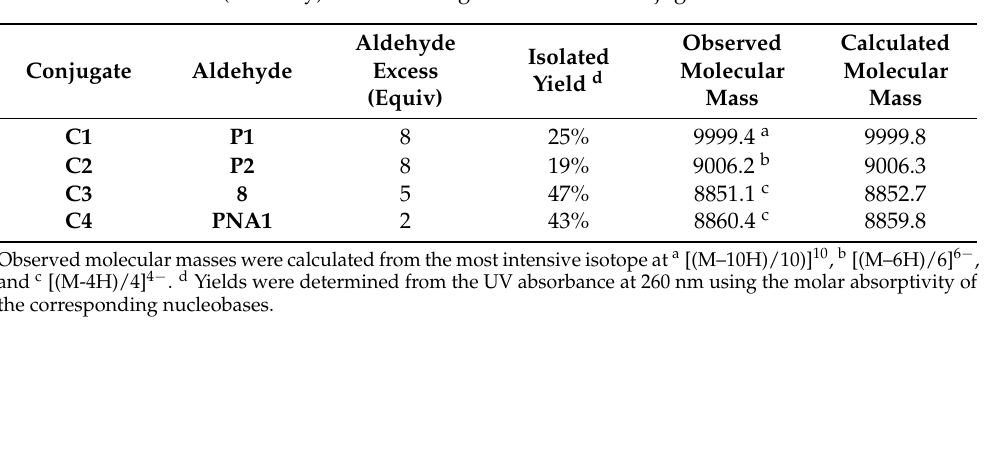
Aldehyde Observed Isolated Excess Molecular Yield d (Equiv) Mass